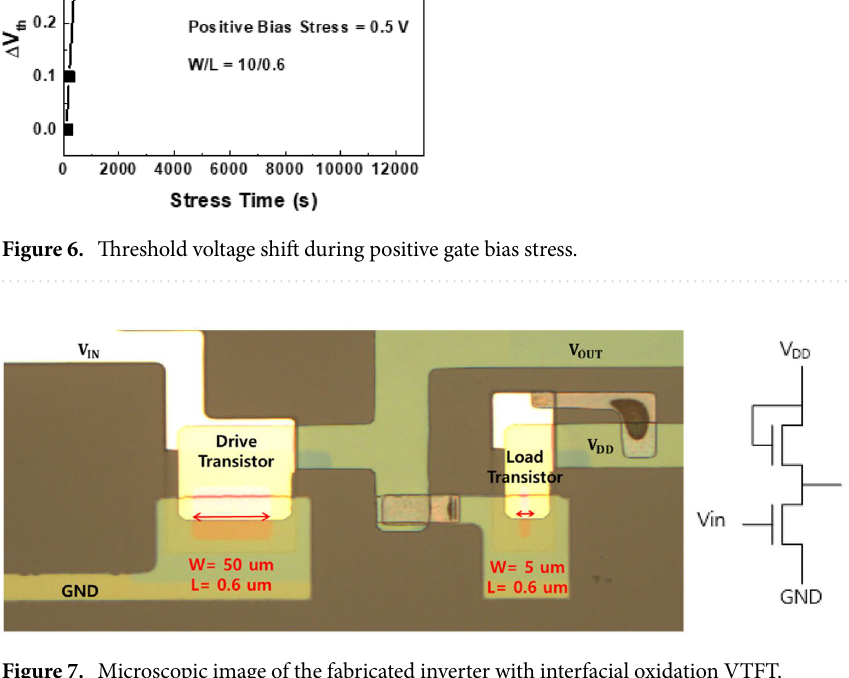
Figure 7. Microscopic image of the fabricated inverter with interfacial oxidation